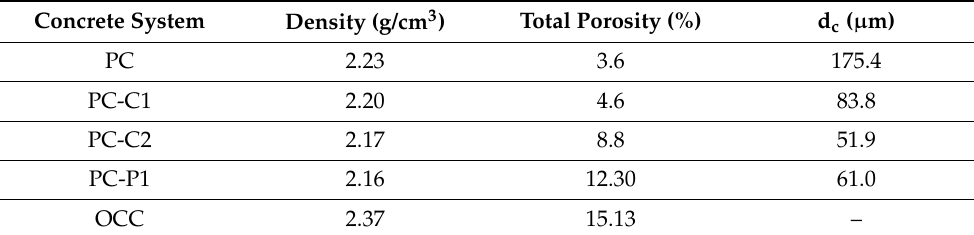
Table 4. Density and porous structure properties of studied concretes.